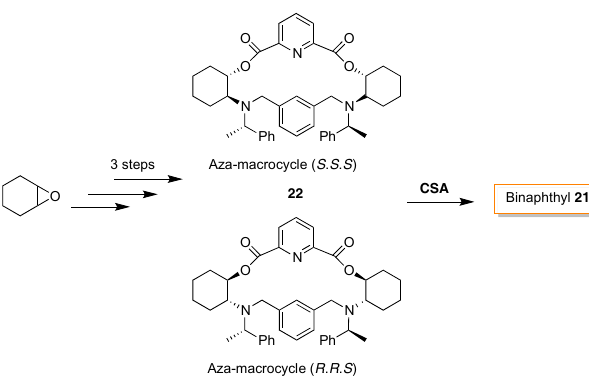
Scheme 18. Chiral discrimination of Binaphtyhl 21 using the aza-macrocycle by 31 P { 1 H} NMR